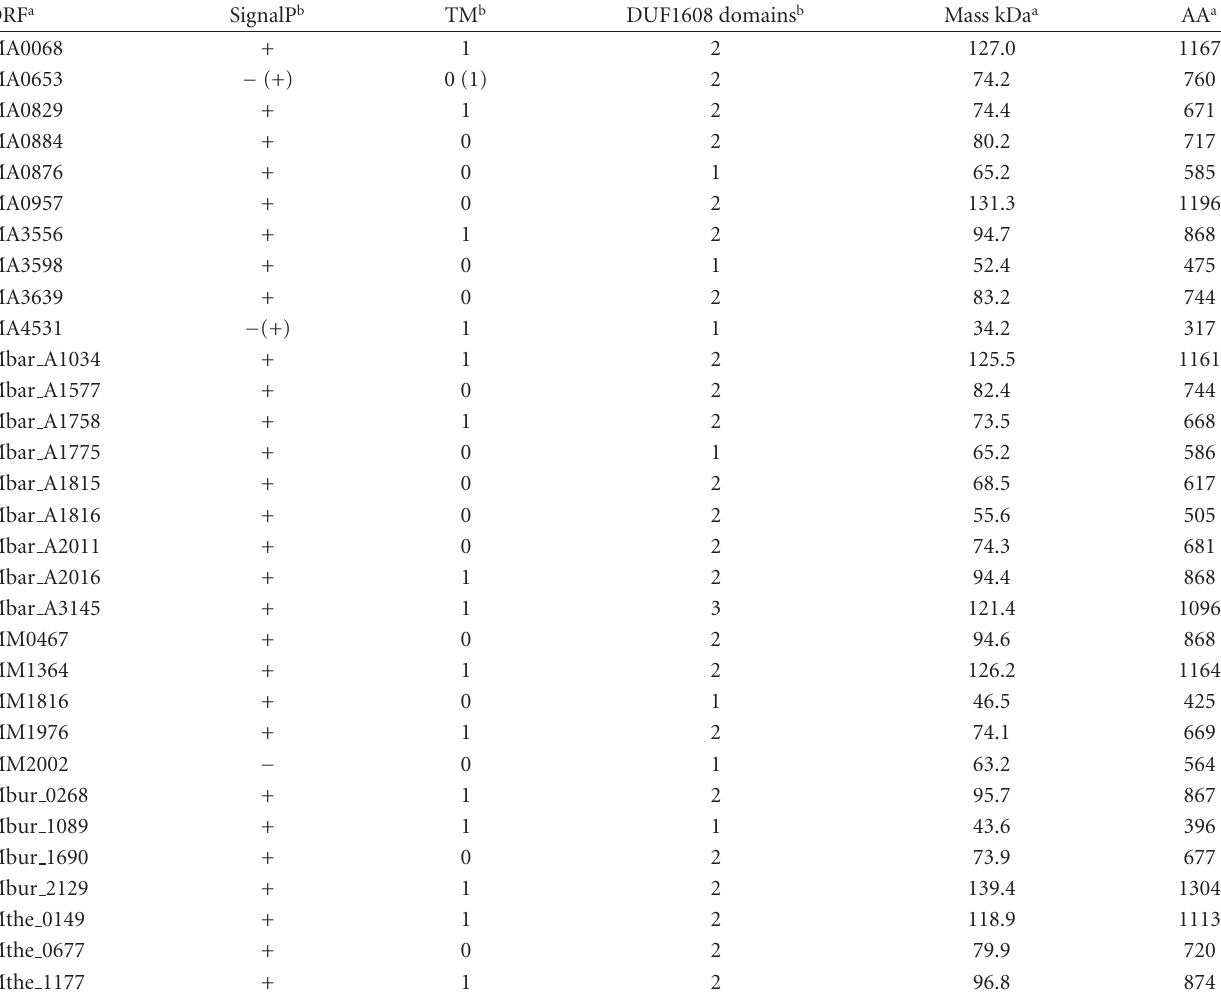
Table 1: Summary of the DUF1608-containg proteins in the methanogenic